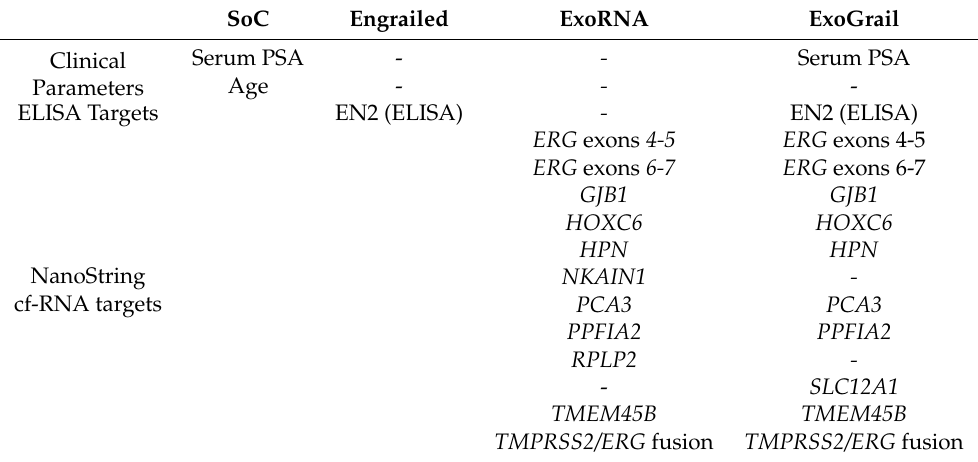
Table 2. Features positively selected for each model by bootstrap resampling and the Boruta algo- rithm. Features are selected for each model by being confirmed as important for predicting biopsy outcome, categorised as a modified ordinal variable (see Methods) by Boruta in ≥ 90% of bootstrap